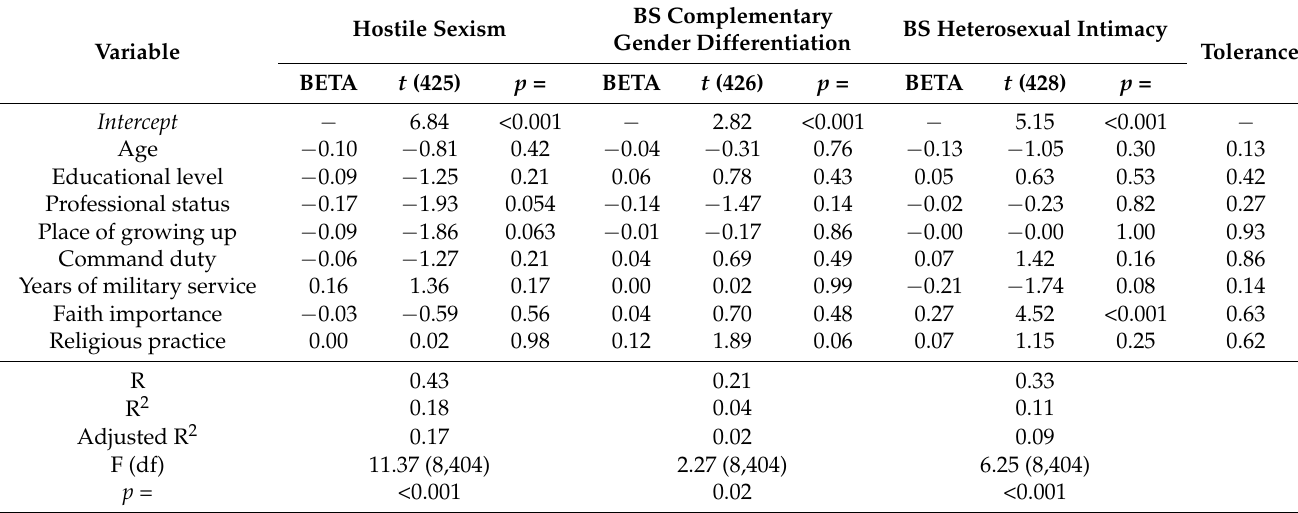
Table 7. Determinants of the three validated sexism measures among